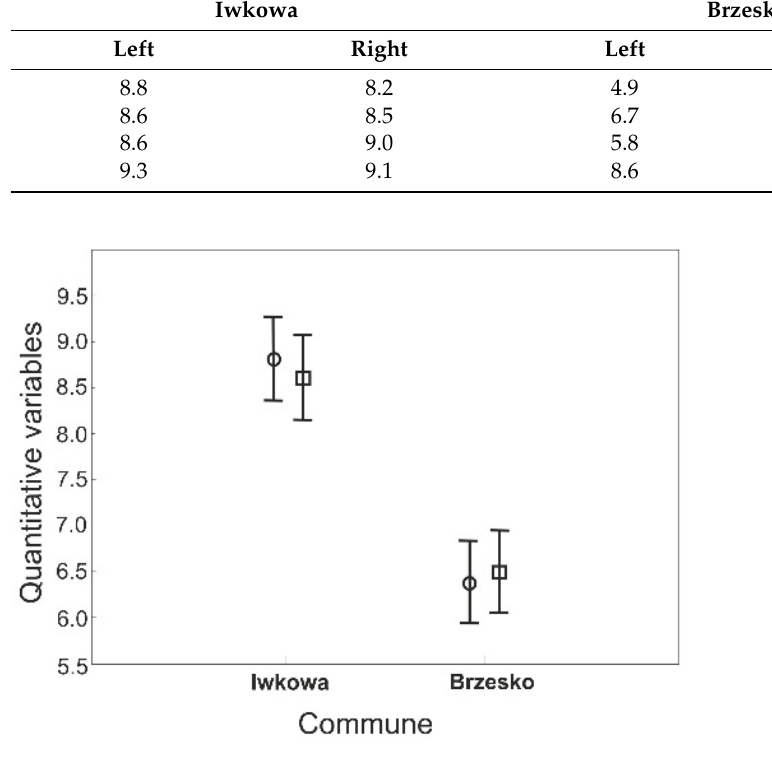
Figure 17. Mean values ± SD of quantitative variables for Iwkowa and Brzesko commune ( γ —right side, ο —left side).